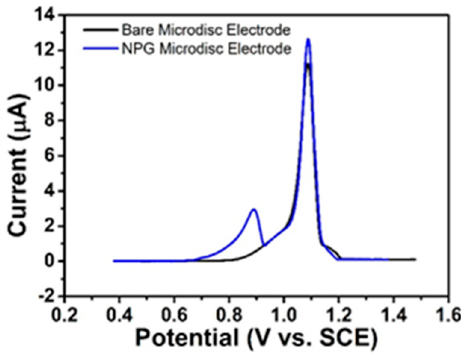
Figure 8. LSVs at bare gold (black)- and NPG-modified microdisc array (blue) electrode arrays vs. SCE at 10 mV s − 1 in Ventolin TM formulation (pH 4) containing 2 mg/mL salbutamol (as sulphate) in 0.0154 M NaCl and 0.05 mM H 2 SO 4 .